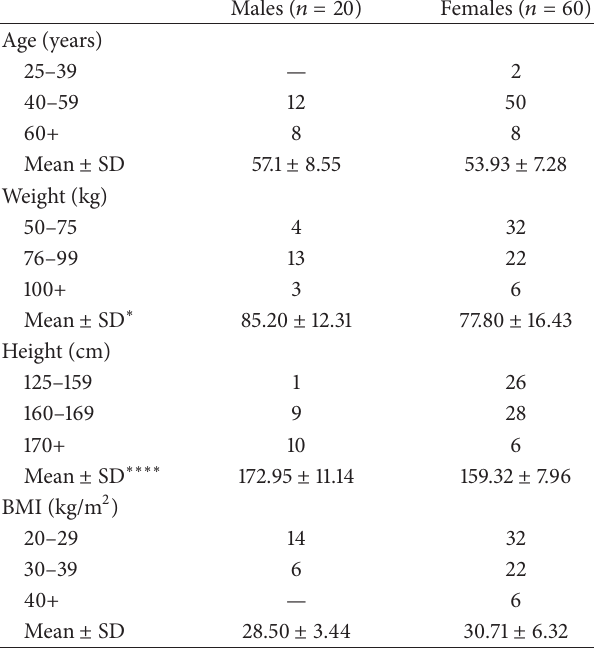
Table 2: Patient characteristics of Bioserve samples ( 𝑛 valid cases